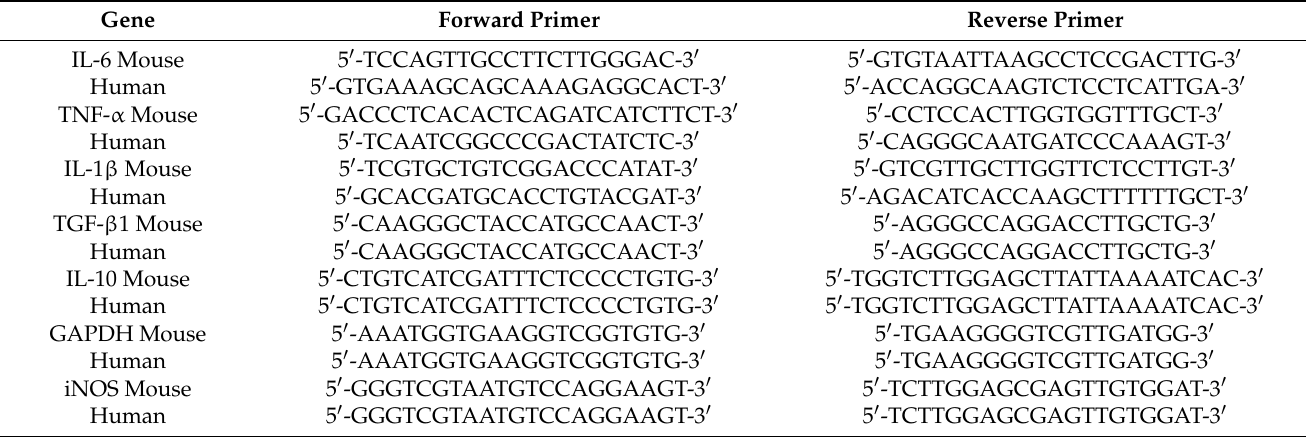
Table 1. Mouse and human primer sequences for genes used for RT-PCR and RT-qPCR. Gene Forward